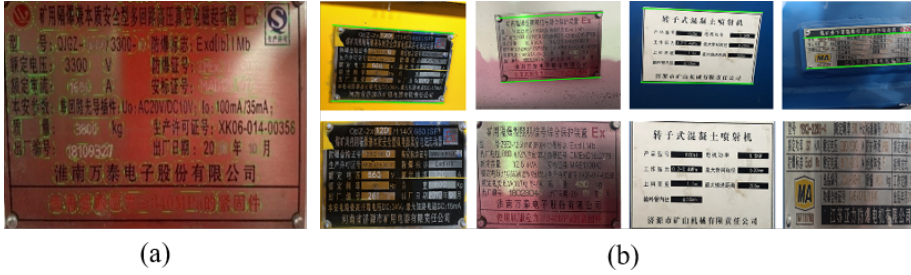
Figure 7. ( a ) Test results after correction process using DBNet. ( b ) The pictures after